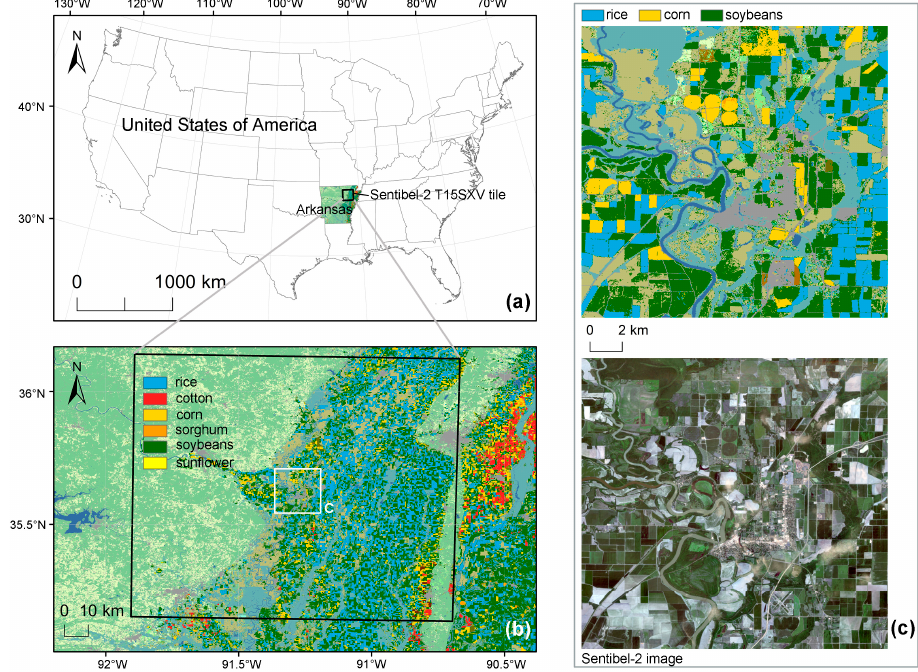
Figure 1. Study area overview. ( a ) Location of the experimental site. ( b ) Main crop type of the study area. ( c ) Details of the study